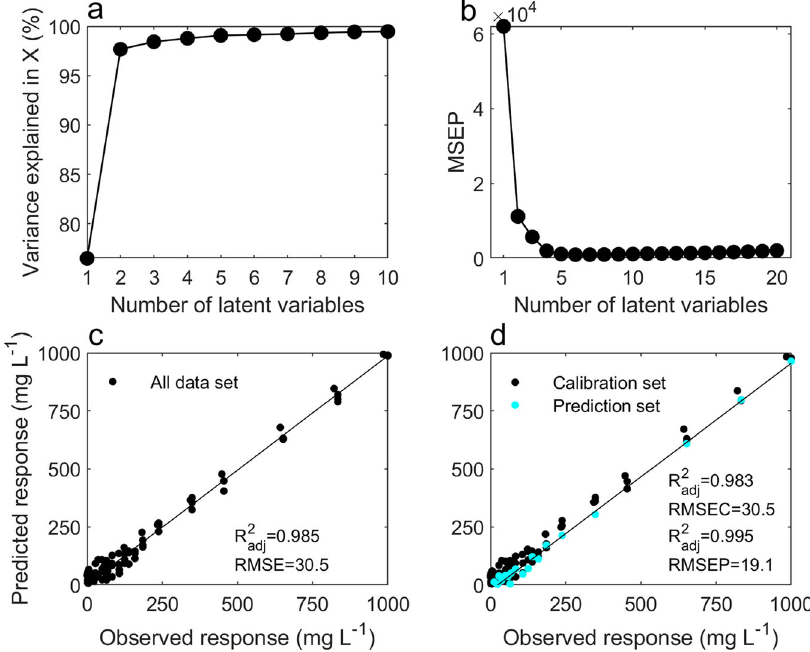
Fig. 3 Characterization of the PLSR model. a Variance explained in the spectra, b mean MSEP values for each latent variable in the model, c regression of all model-predicted concentrations on known (observed) values, and d validating the model with 80% training (calibration) set and 20% testing (prediction) set.